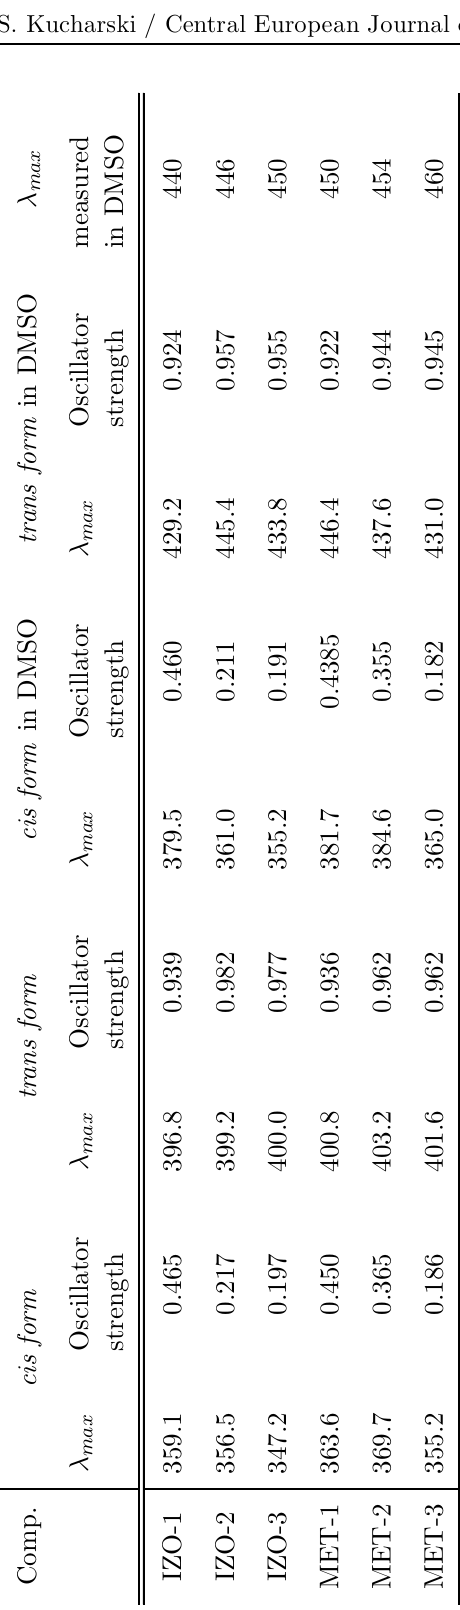
Table 2 Calculated data for the UV-VIS spectra of the